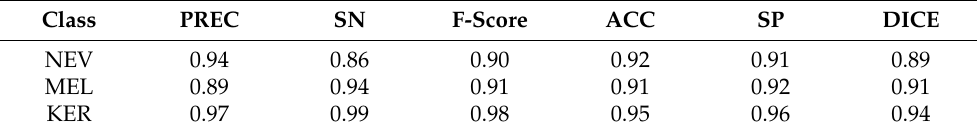
Table 6. The optimized CNN model evaluated on the ISIC2017